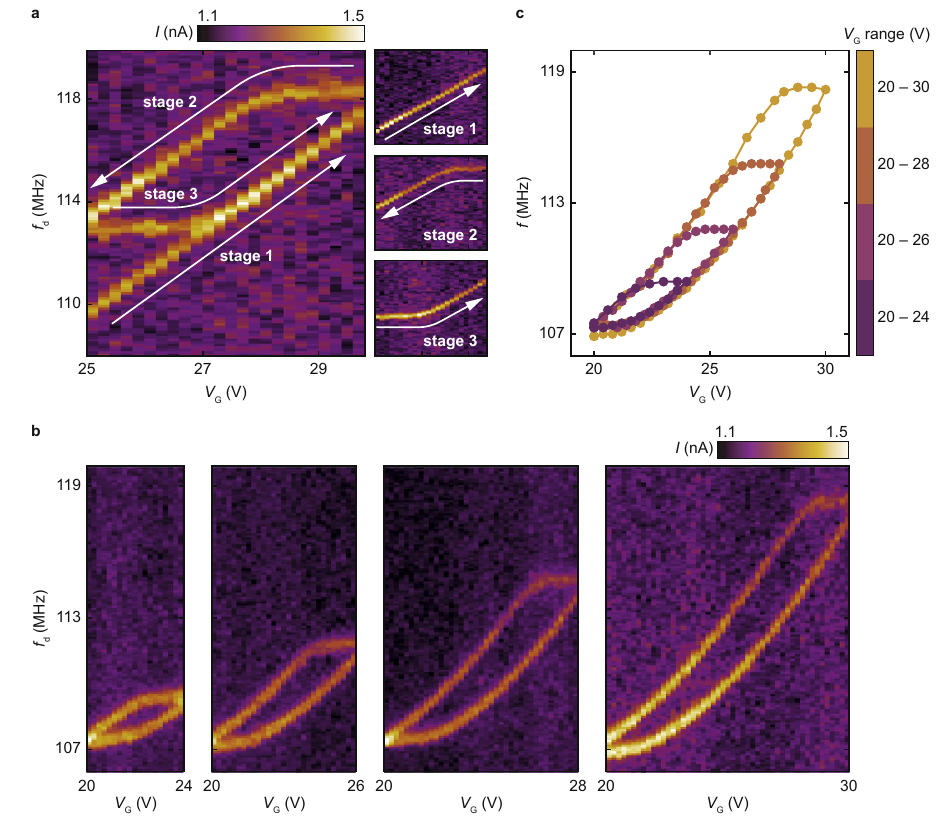
Fig. 2 | Resonant frequency loops and their dependence on V G range. panel shows the superimposed spectra from stages 1 – 3. b Frequency response a FrequencyresponseofthemodewhoseresonantfrequencyisshowninFig.1das measured upon increasing and decreasing V G over various V G ranges. The panels a function of f d and V G . The response is extracted from the spectrum of current I are made by superimposing data measured with increasing V G and data measured which peaks at the resonant frequency. In stage 1, V G is stepped from 20 V up to with decreasing V G . c Superimposed dependences of the resonant frequency f on ≈ 30 V down to 25 V.In stage 3, V ≈ 30 V.In stage 2, V V G isstepped from G isstepped G extracted from the four panels in b . from25Vupto ≈ 30Vagain.Stages1 – 3aredonesequentiallyandinonego.Theleft